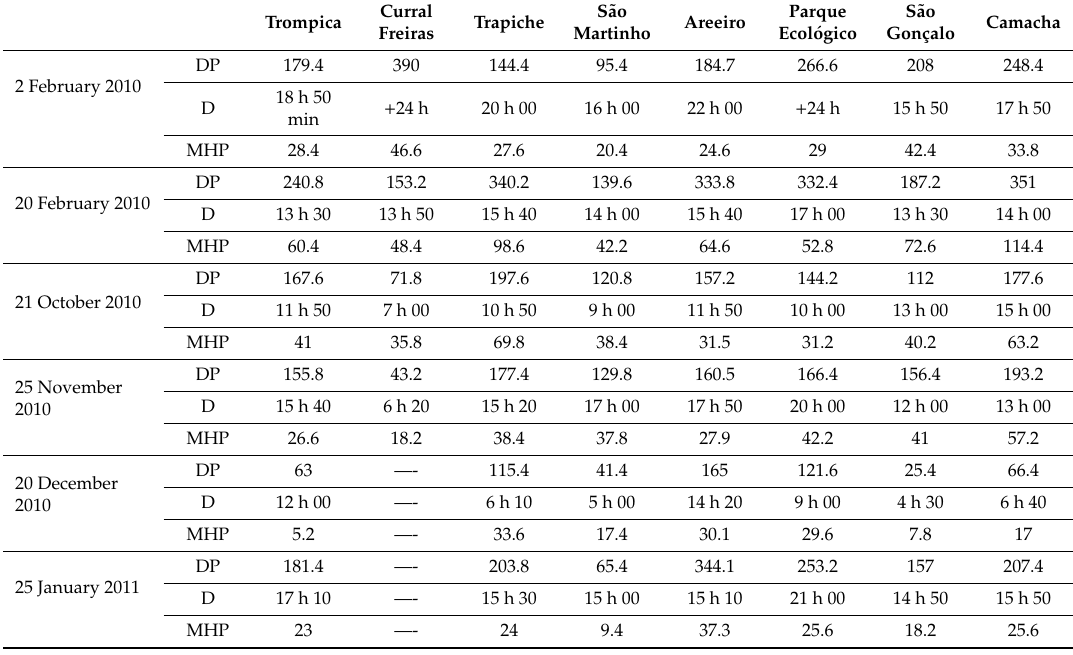
Table 8. Summary of precipitation values associated with intense events from 2009 to 2011.